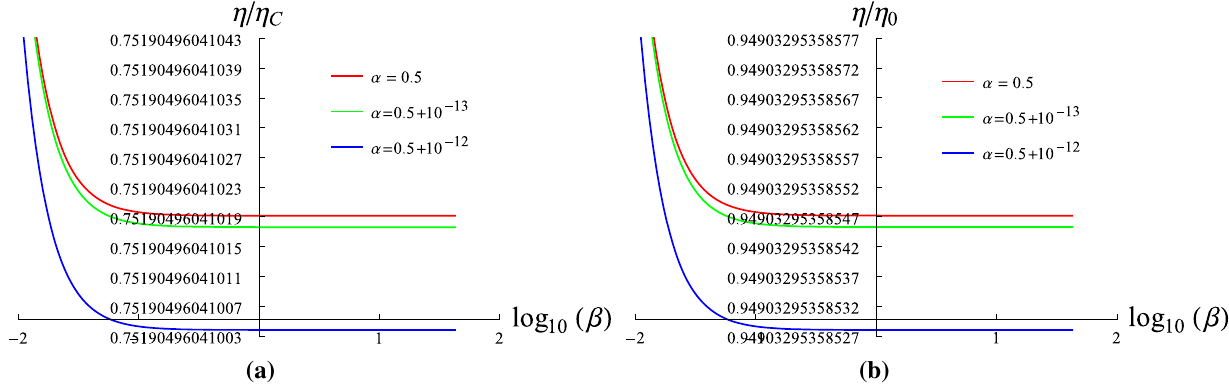
Fig. 8 For the case α (cid:7)= 0 and β (cid:2) ∞ . a The ratio η/η C vs log 10 (β). b The ratio η/η 0 vs log 10 (β) (see the caption of Fig. 2 for parameter values)